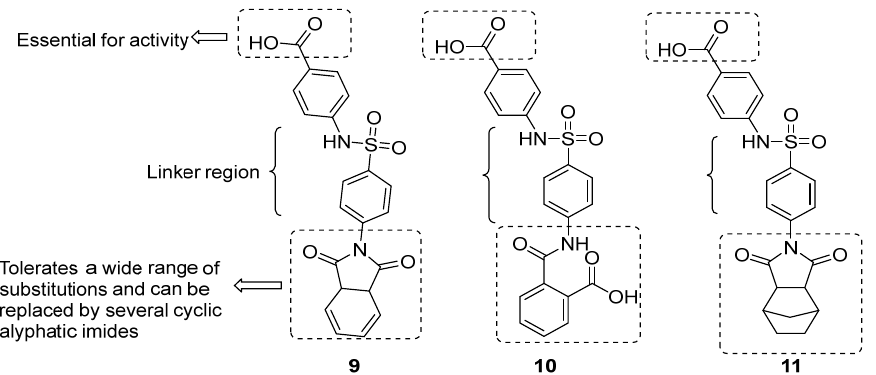
Figure 8. Chemical structures of compounds 9 – 11 .